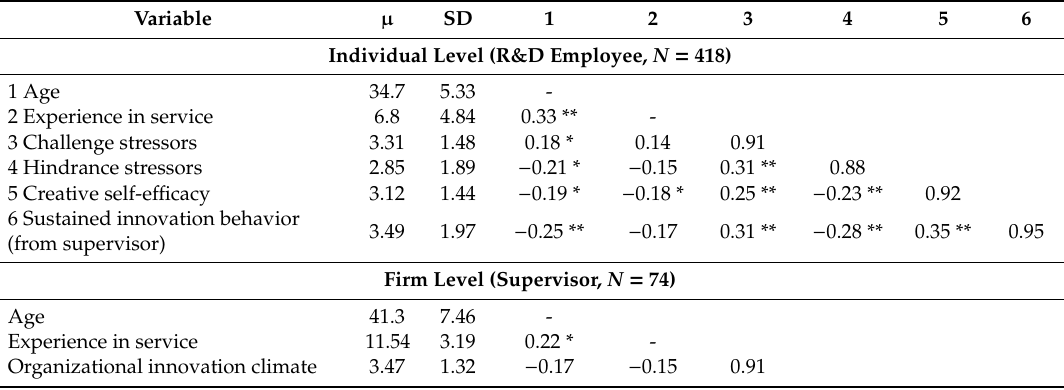
Table 1. Mean scores, standard deviations, and correlations among study variables.